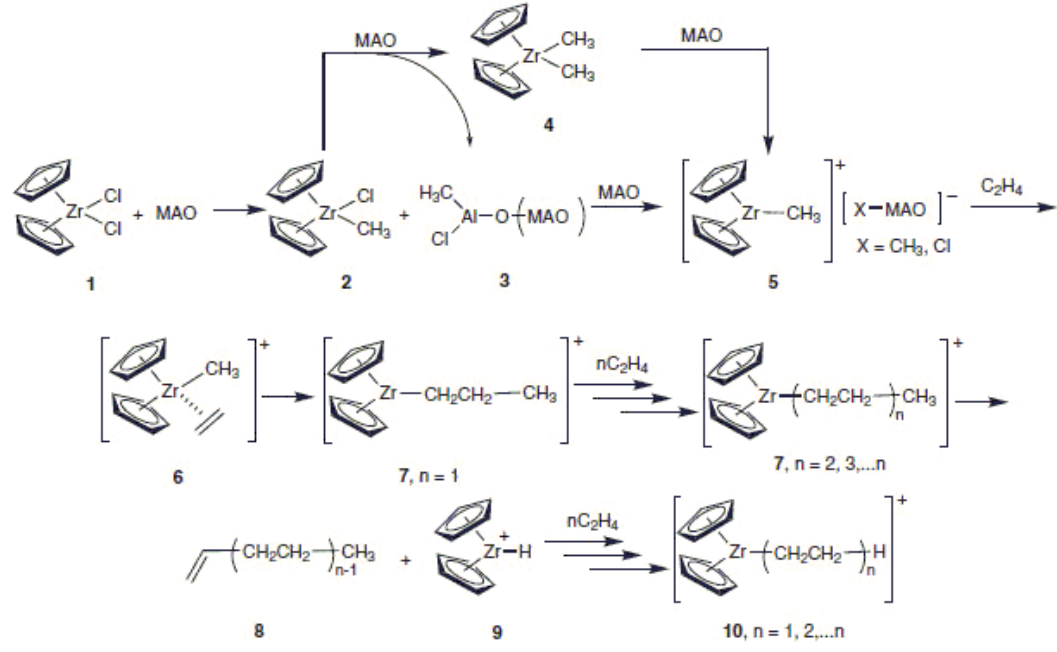
Figure 2. Proposed mechanism of Ziegler-Natta polymerization of C homogenous catalyst ZrCp MAO = methylalumoxane), reprinted with permission from [17], copyright 2011 the Brazilian Chemical Society.